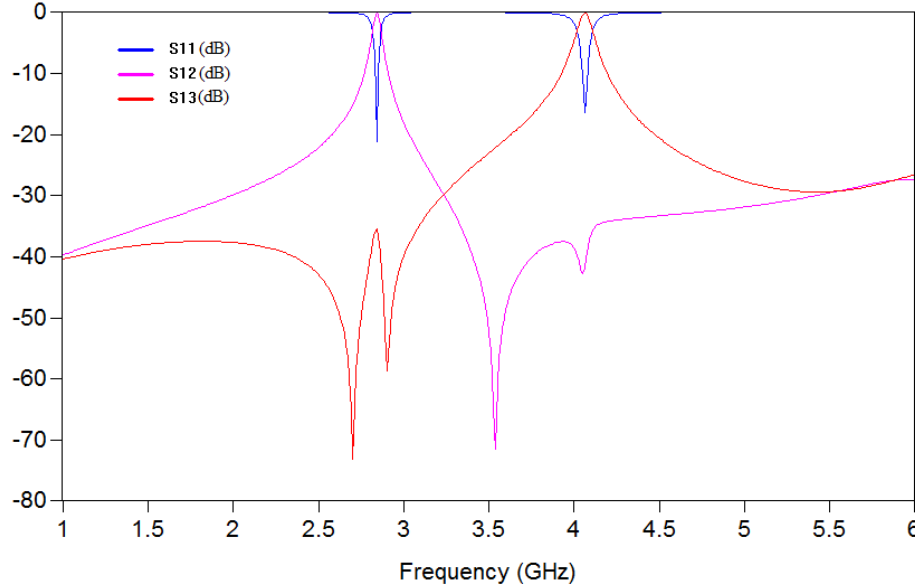
Figure 7. Simulated S11 , S12 , and S13 scattering responses for the diplexer based on the Kappa substrate.